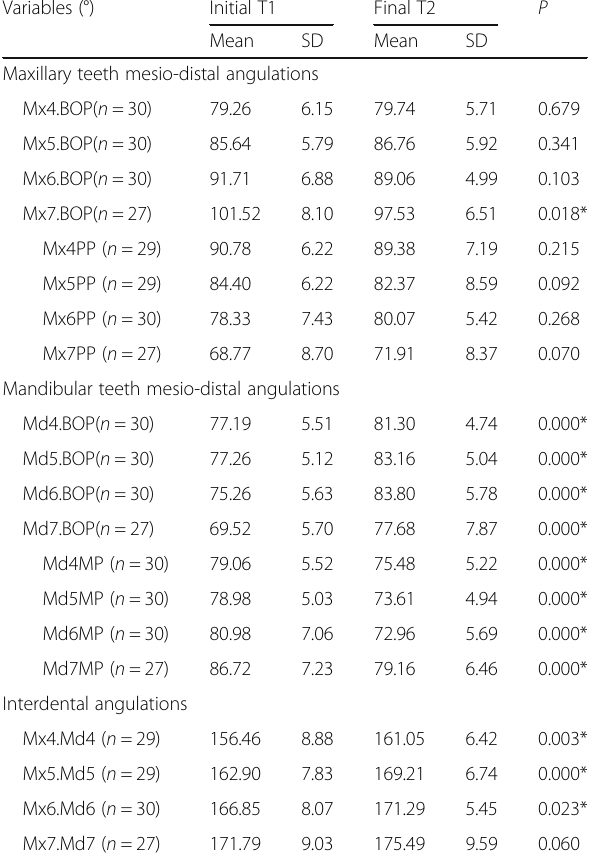
Table 3 Comparison of cephalometric variables between pretreatment and posttreatment stages for the extraction group (dependent t tests)